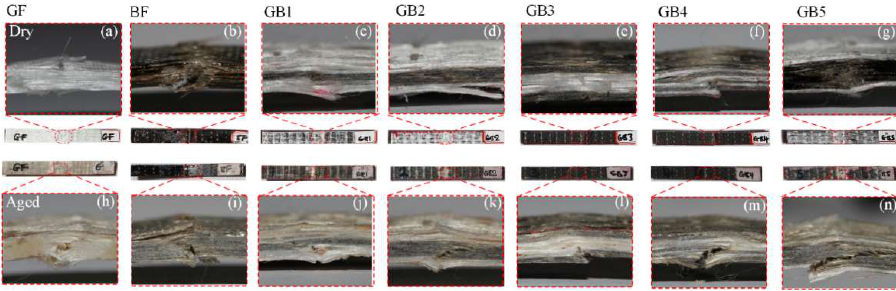
Figure 17. Photograph of flexural test specimen in dry ( a ) GF ( b ) BF ( c ) GB1 ( d ) GB2 ( e ) GB3 ( f ) GB4 ( g ) GB5 and seawater aged condition ( h ) GF ( i ) BF ( j ) GB1 ( k ) GB2 ( l ) GB3 ( m ) GB4 ( n )